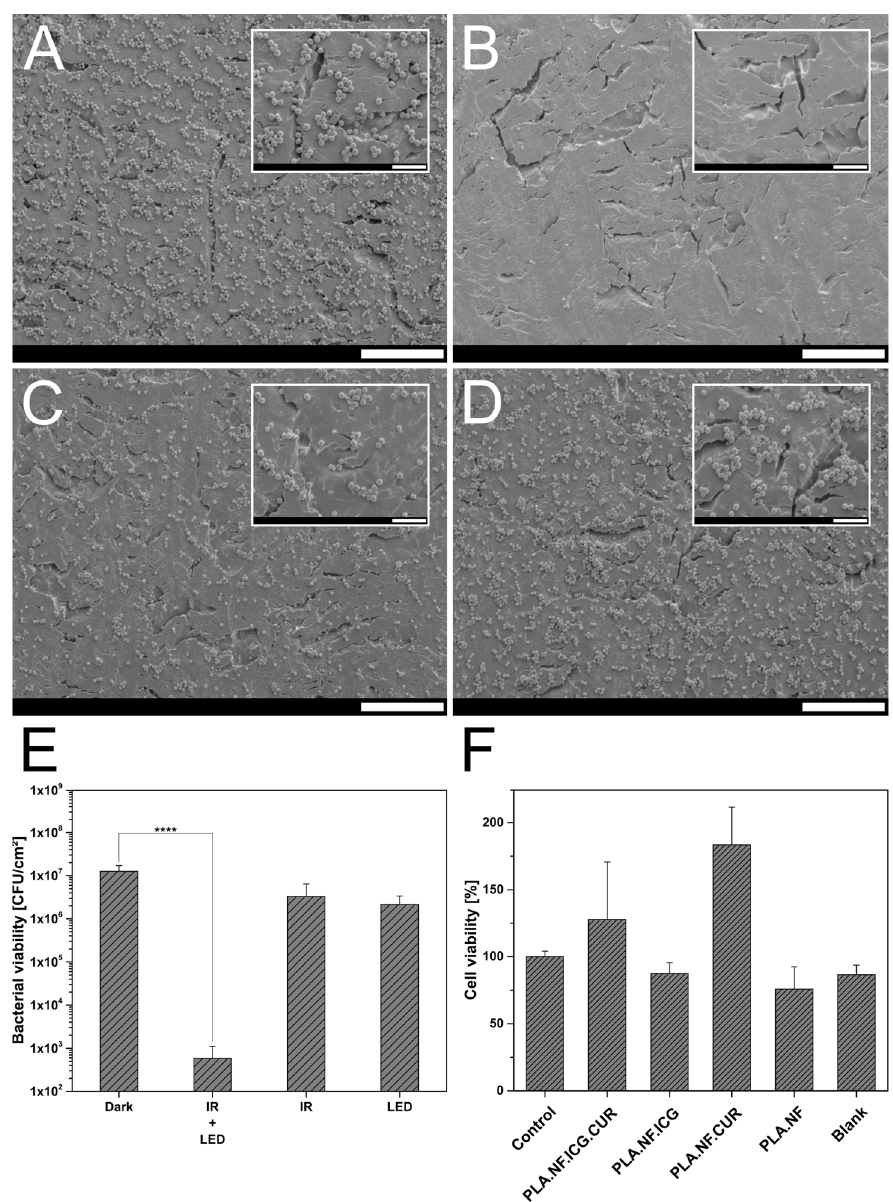
Figure 5. ( A – D ): SEM images of the different irradiated adhered bacteria from Staphylococcus sapro- phyticus subsp. bovis ( S. saprophyticus ) treated with PLA.NF.ICG.CUR. ( A ) unirradiated bacteria, ( B ) irradiated with a laser module (IR: 810 nm) and an LED panel (LED: 457 nm) for 30 min each, ( C ) irradiated with a laser module (IR: 810 nm) for 30 min, ( D ) irradiated with an LED panel (LED: 457 nm) for 30 min. Scale bars represent 30 and 7 µm for the insets. ( E ) Bacterial viability of treated adhered bacteria from Staphylococcus saprophyticus subsp. bovis ( S. saprophyticus ) treated with PLA.NF.ICG.CUR after irradiation with a laser module (IR: 810 nm) and an LED panel (LED: 457 nm) for 30 min each. Dark represents unirradiated bacteria. Probability values of “****” p < 0.0001 were considered significant. ( F ) Cellular viability of L929 cells after incubation with PLA.NF.ICG.CUR, PLA.NF.ICG, PLA.NF.CUR, and PLA.NF. An empty well was used as control and empty aluminum foil on which the fiber samples were supported was used as blank.